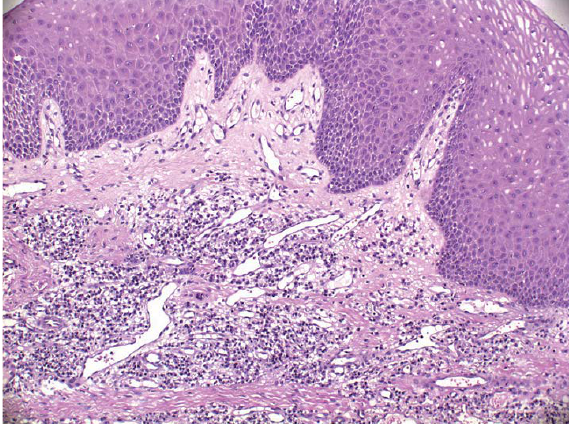
Figure 1. Photomicrographs of gingival specimens showing a large number of the diffuse lymphocyte-rich mononuclear cell infiltrate under the superficial epithelium, especially around vascular structures. Also, microvascular proliferation in the vicinity of inflammation is also clearly detected. (Hematoxylin and eosin x200) (CP group).